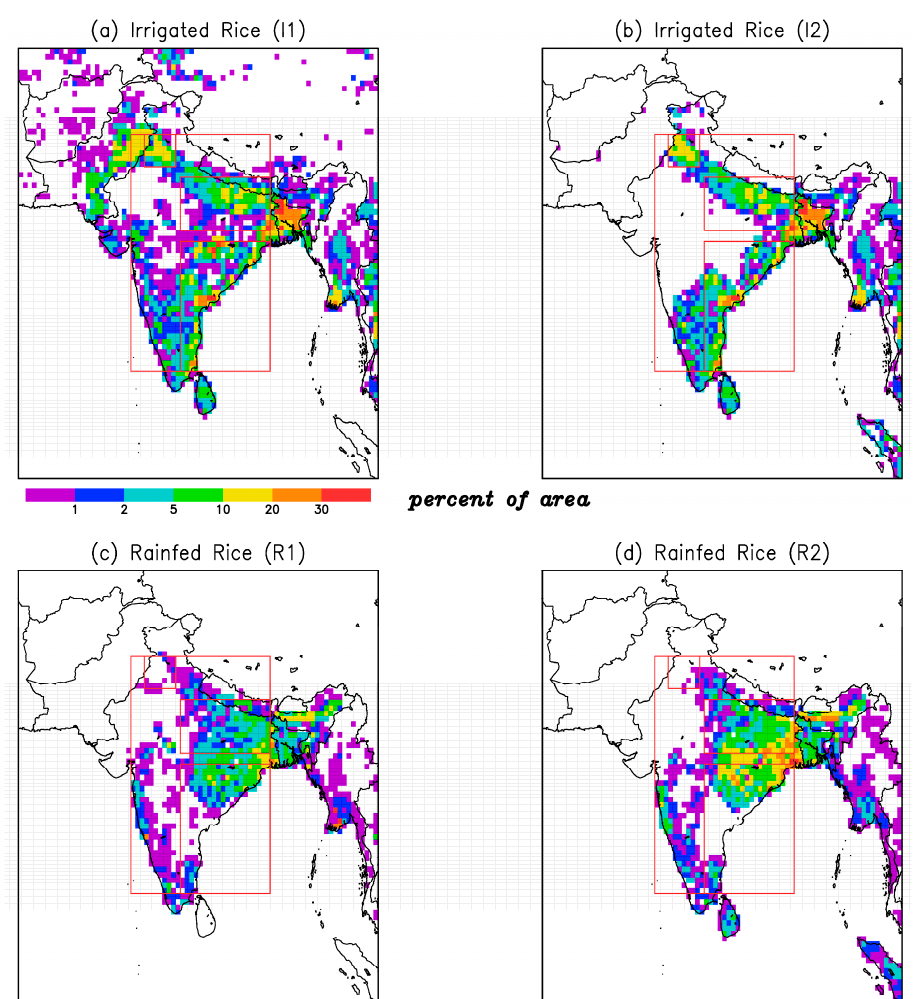
Figure 2. Spatial distribution of irrigated and rainfed (flooded lowland) rice fields used for the weighted averages of the climatic indicators according to MIRCA2000 global calendar data set adopted in this study. Two irrigated cycles ( a , b ) and two rainfed/flooded cycles ( c , d ) are considered (see Figure 1). The red boxes highlight the main hydro-climatic regions where we focus the sub-national level analysis. The larger box (72.5–88 ◦ E, 10–32 ◦ N) represents the Indian continent, excluding Assam in the northeast. The other boxes represent, respectively, Punjiab and Haryana in the northwest (74–77.5 ◦ E, 29–32 ◦ N), the Ganges basin (78–88 ◦ E, 23–28 ◦ N), and the southeastern catchments region (78–88 ◦ E, 10–22 ◦